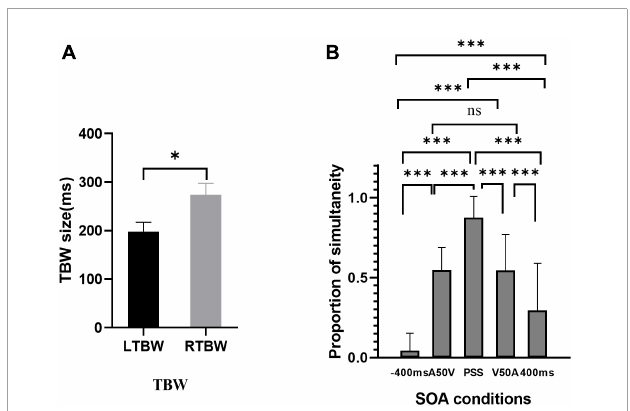
FIGURE3 The results of behavior responses in two experimental sessions. (A) Auditory and visual leading temporal binding windows across subjects are significantly different. (B) Behavioral results of the EEG session. The proportion of synchronous response is shown for each stimulus onset asynchronous (SOA). ∗ p < 0.05, ∗∗∗ p < 0.001. ns, not